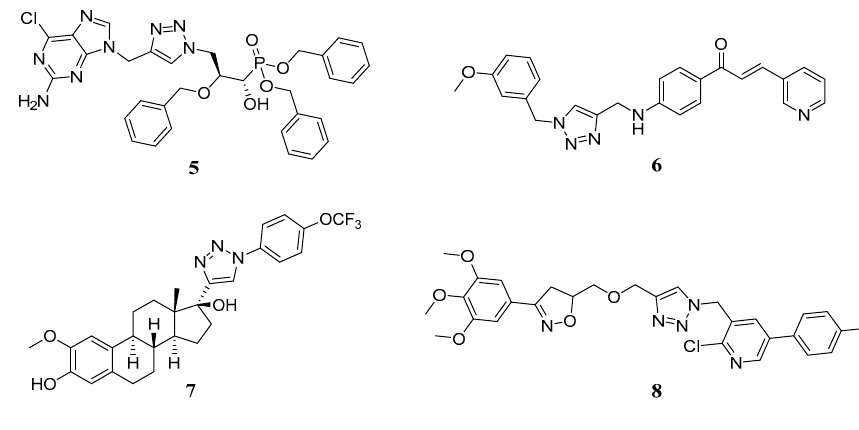
Figure 3. Antitumor 1,2,3-triazoles.